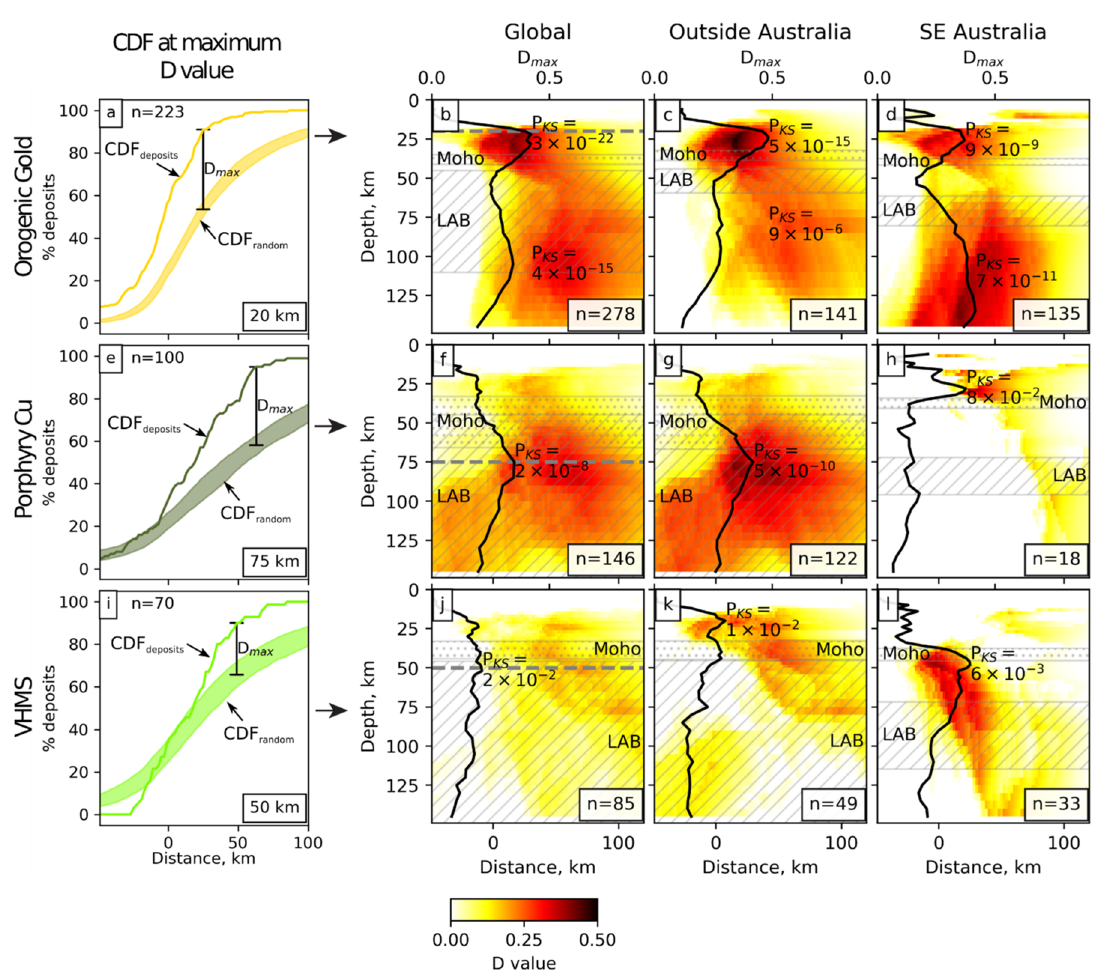
Figure 2. Cumulative distribution function of the distance of deposits (CDF deposits ) compared to random locations (CDF random ) from the 100 Ωm contour. ( a – d ) Orogenic gold, ( e – h ) porphyry copper, and ( i – l ) VHMS deposits. Left panel ( a , e , i ) shows CDF deposits , CDF random , with the maximum difference D max = CDF deposits − CDF random indicated on the plots as a vertical bar, at a depth corresponding to the maximum D value in the global assessment of each deposit type (indicated by grey horizontal dashed lines in b , f and j ). The range on the random locations represents the mean ± 1 standard error estimated from 100 realisations of random locations. Right three panels show the difference D = CDF deposits − CDF random in colour as a function of depth and distance of deposits from the contour, in resistivity models from the global dataset ( b , f , j ), outside Australia ( c , g , k ), and within southeast Australia only ( d , h , l ). In these images, D max is shown as a function of depth as a black line, and the depths of the Moho 41–43 and LAB 11,44 are shown as grey semi-transparent dotted and hatched regions, respectively, with the range indicating the 10th to 90th percentile of depths directly beneath deposits. The n value indicates the number of deposits that were included in the analysis for that category, e.g. n = 278 in ( b ) indicates there are 278 orogenic gold deposits included in the global